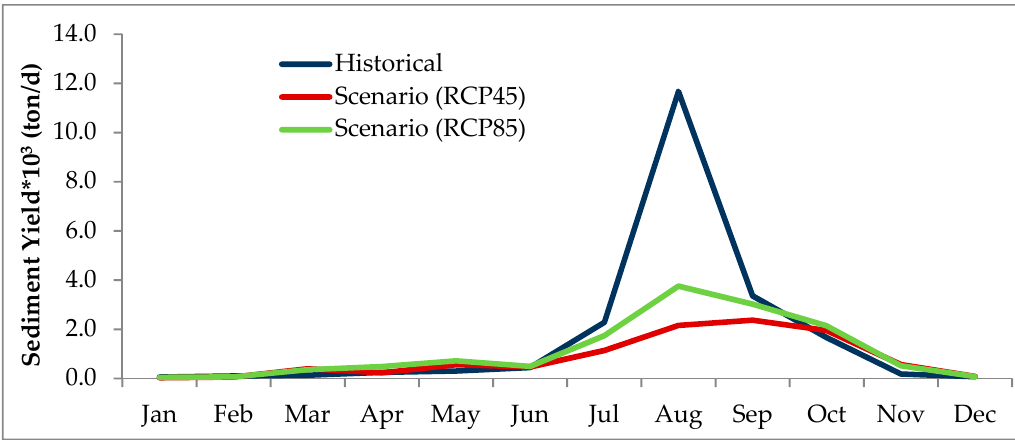
Figure 9. Sediment yield in the Ketar River in the future scenario as compared to the historical period (1985–2010).